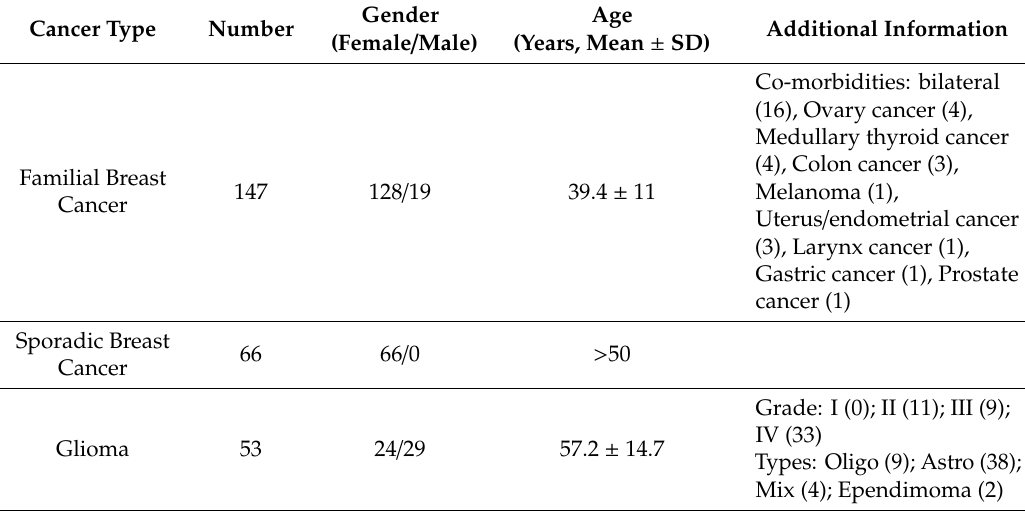
Table 4. Characteristics of the patients included in the